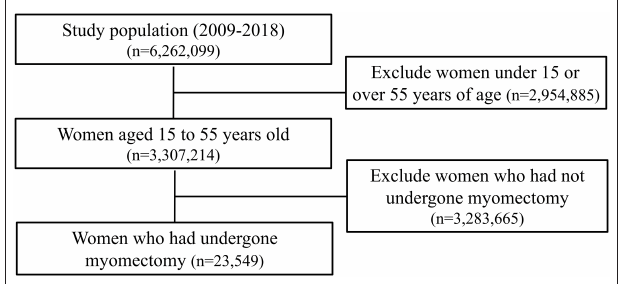
FIGURE 1 | Flowchart showing the selection of the study